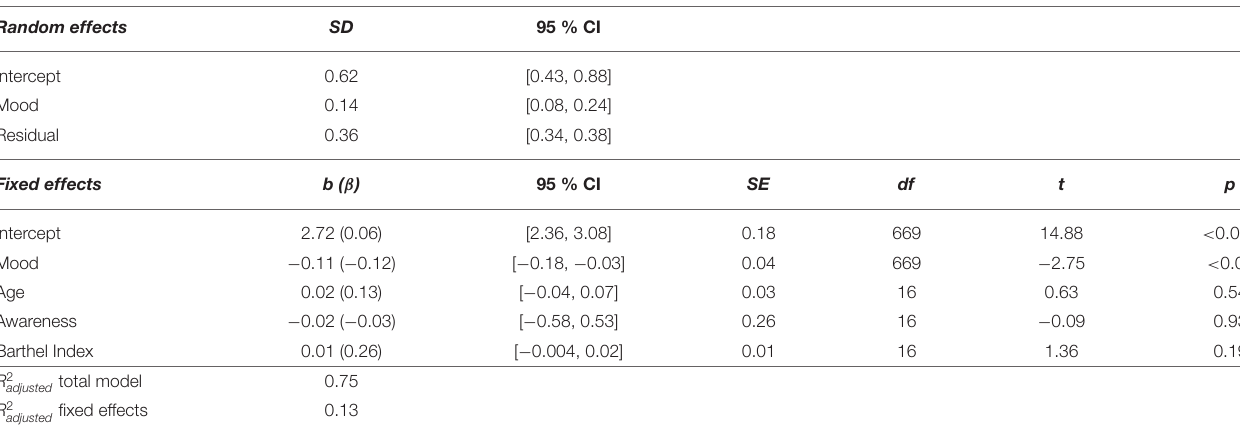
TABLE 1 | Random intercepts and slopes model with patients’ current mood (t0) as the level 1 predictor, patients’ age, awareness of illness, and the Barthel Index as the level 2 predictor and patients’ self-reported functionality as the dependent variable.